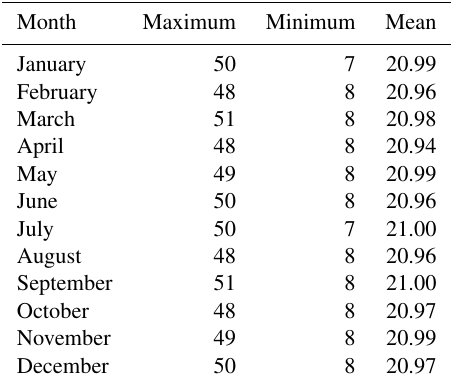
Table 11. The number of GIIRS selected stars in every month.